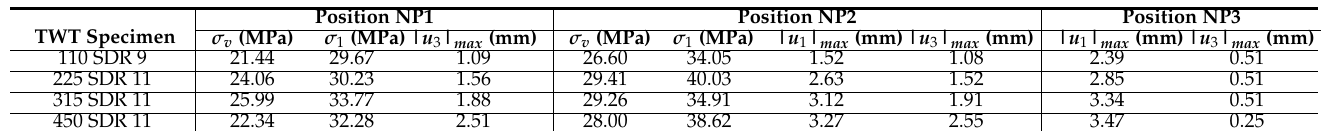
Comparing 110 SDR 9 and 225 SDR 11 WT specimens (Figures 15a and 16a,